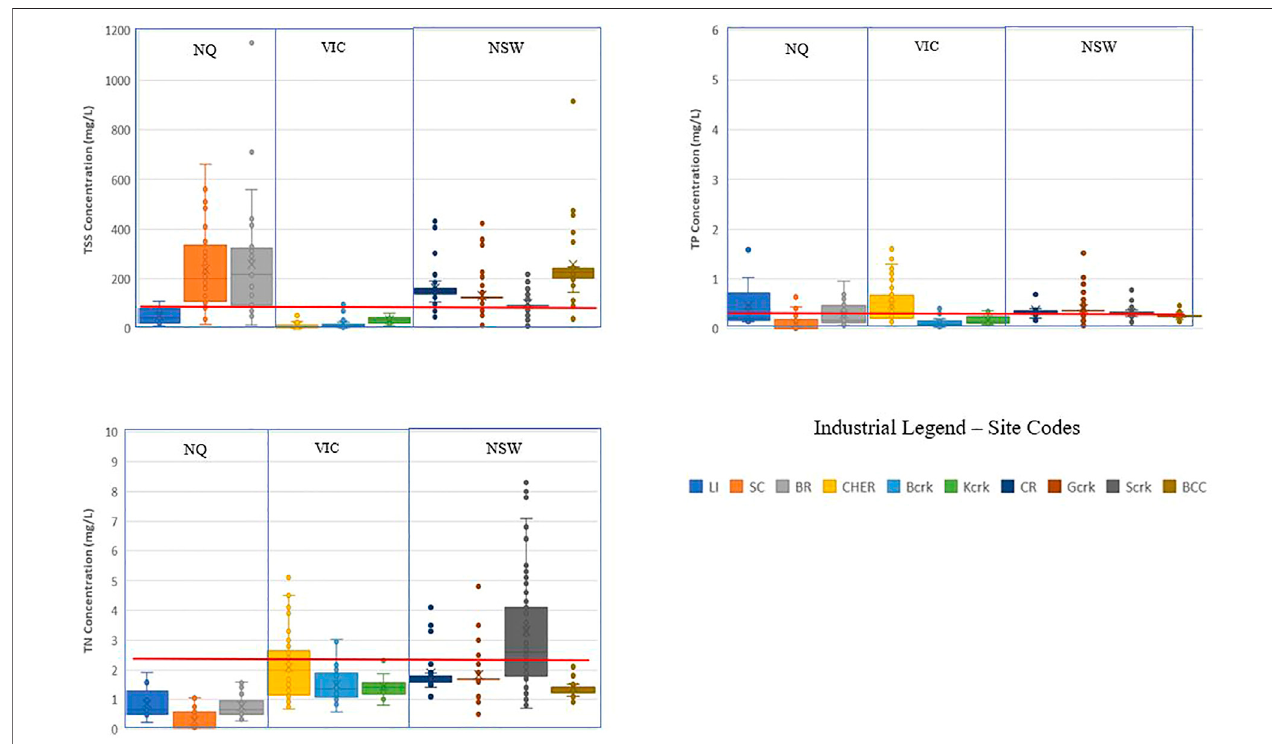
FIGURE 5 | Summary industrial landuse TSS, TP and TN concentrations for each site by geographic region, with typical values shown in red (WbD, 2018).